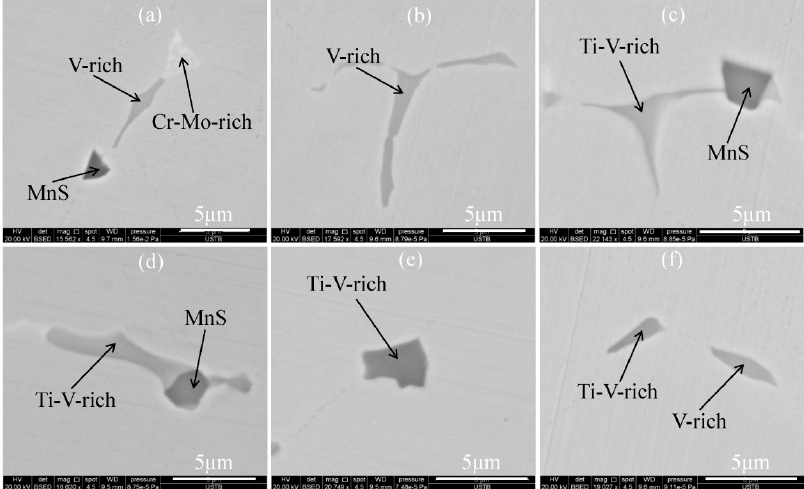
Figure 4. Two-dimensional morphologies of the inclusions in the samples. ( a , c , d ) MnS; ( a , b ) V-rich; ( c , d , e , f ) Ti–V-rich.